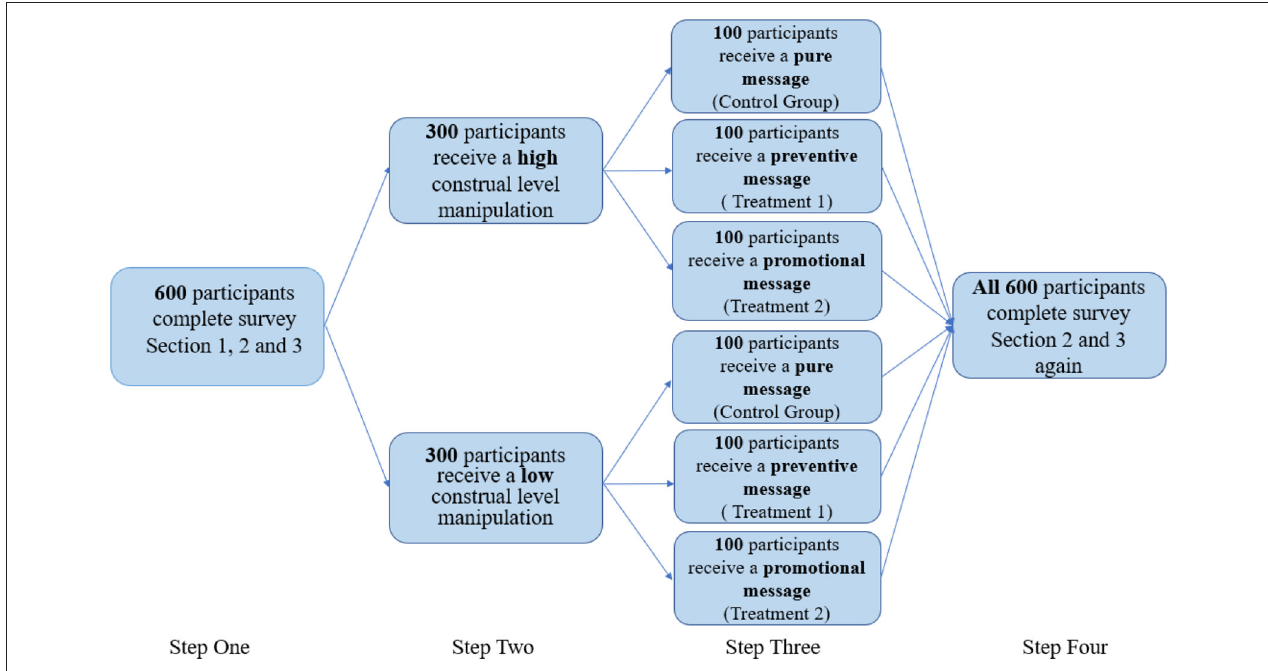
FIGURE 1 | Experimental